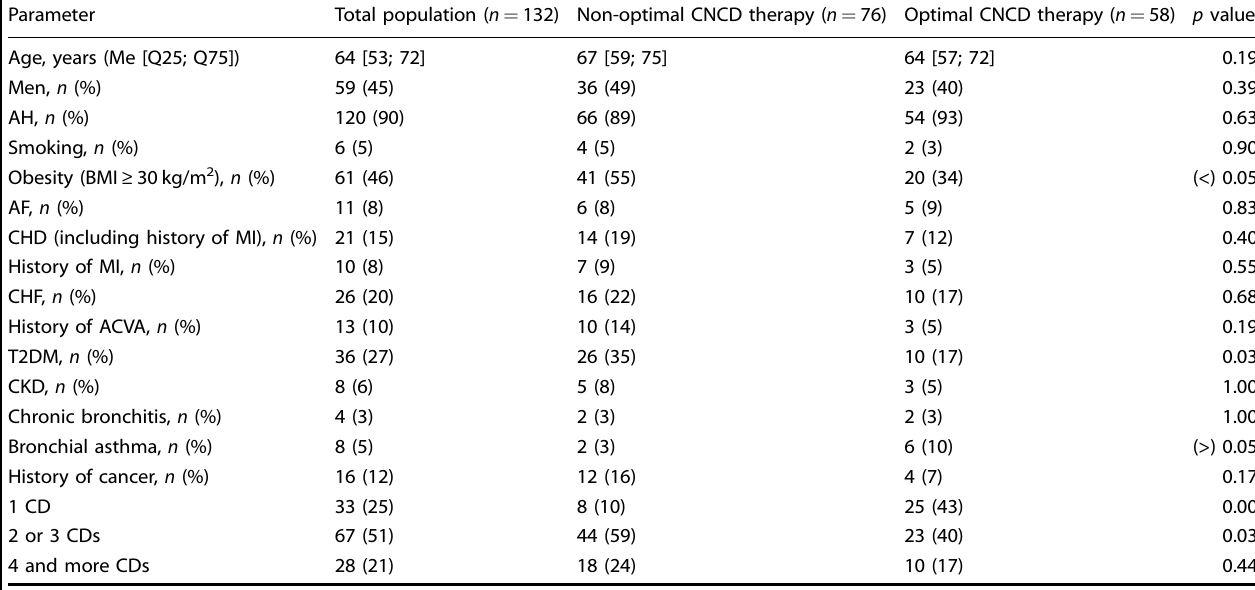
Table 1. Study groups by demography, medical history, and clinical picture.